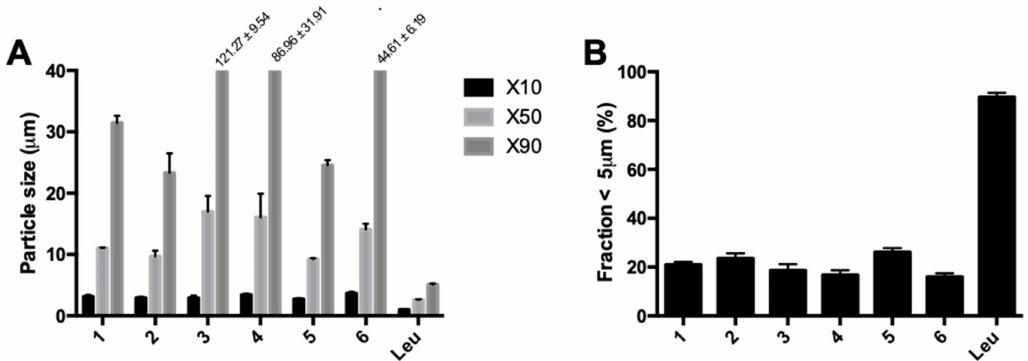
Figure 7. The laser di ff raction data on the di ff erent samples spray dried in the B-290. Each sample was spray dried twice and each laser di ff raction measurement was performed three times. ( A ) shows the X10, X50, and X90, while ( B ) shows the fraction < 5 µ m. The x -axis labels refer to the conditions applied